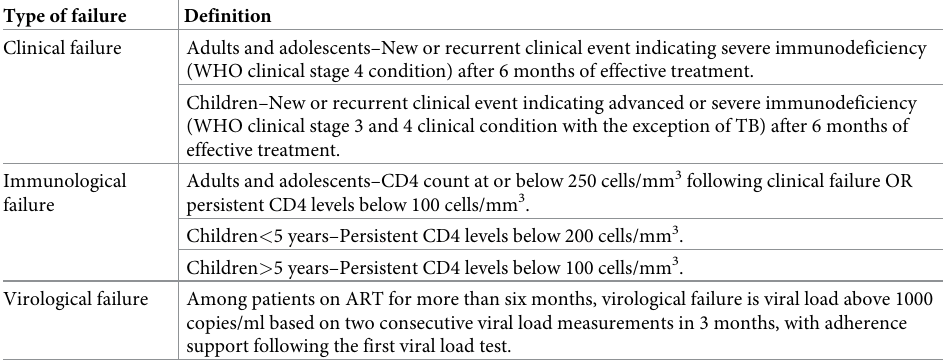
Table 1. WHO definitions of clinical, immunological and virological